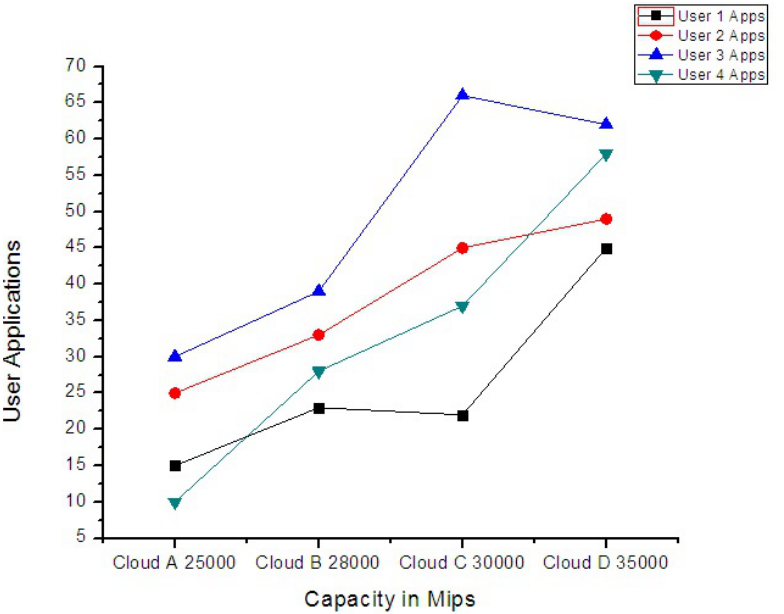
Figure 12. Applications bursting into various